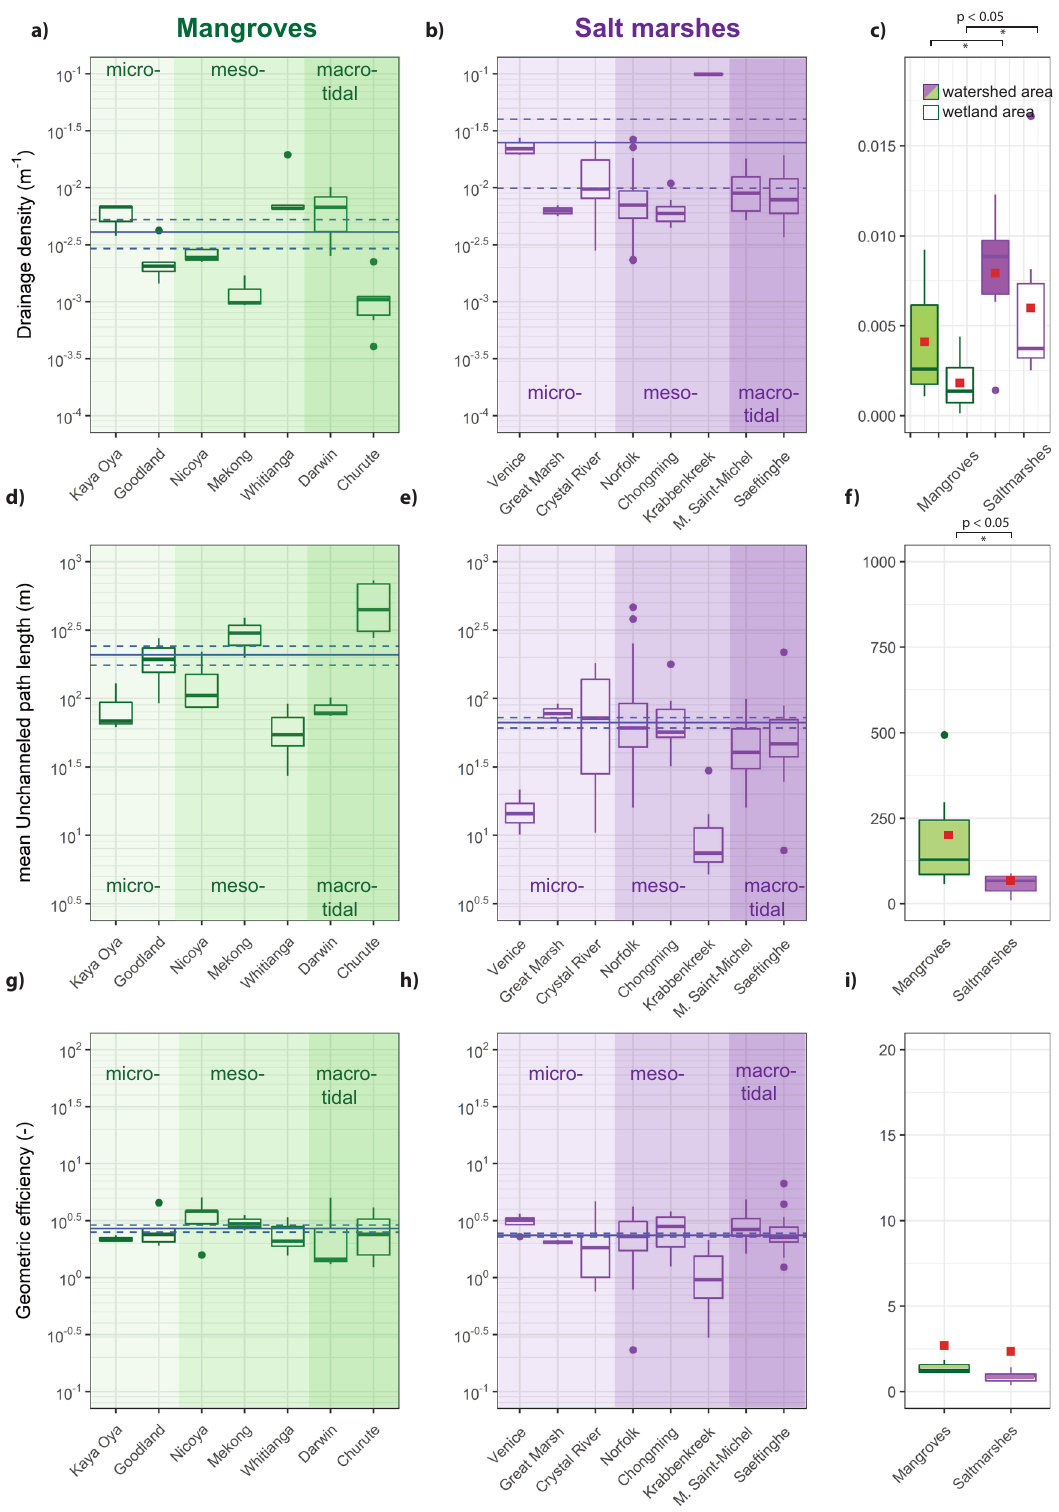
Fig. 2 Channel metric comparisons between mangrove and salt marsh systems. Comparison of drainage density (D), mean unchanneled path length (mUpl) and geometric ef fi ciency ( l H = mUpl ) between mangroves and salt marshes; a , d , g and b , e , h present above proxies for each system per delineated watershed, with mean values marked by solid-blue lines, and the standard error from the mean value marked by blue-dashed lines; c , f , i All proxies averaged per location and grouped between mangrove and salt marsh environments, red dots constitute average values, the white box-plots in ( c ) represent the drainage density based on the entire wetland areas. Statistically signi fi cant differences are indicated with an asterisk (*), based on two-sided two sample Wilcoxon-tests. Tidal range did not exert a signi fi cant impact on network proxies (Supplementary Fig.